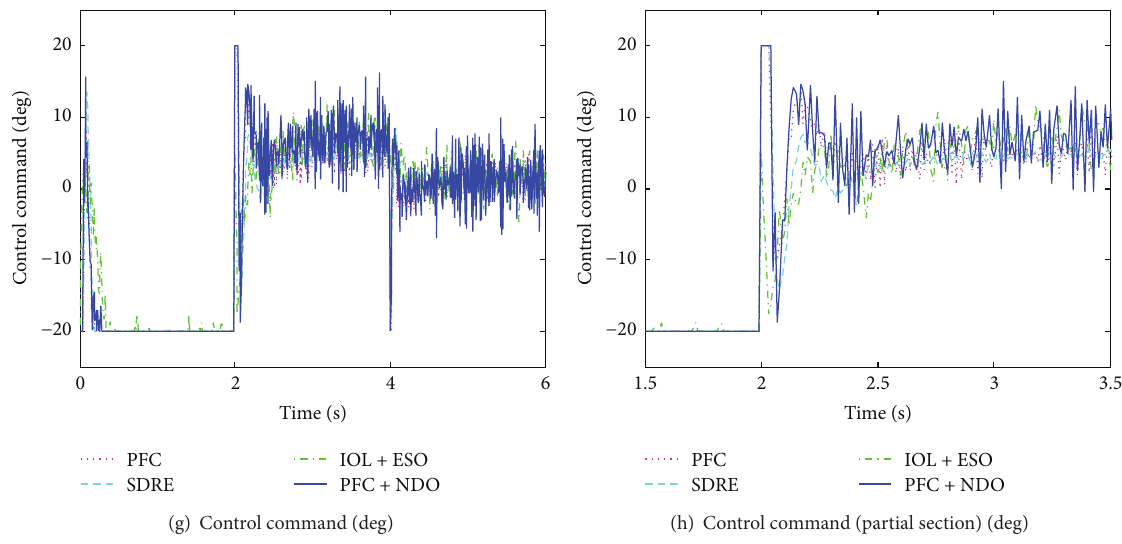
Figure 6: Simulation responses of saturation and the estimate performance of the NDO with measurement noise in the case of positive uncertainties and